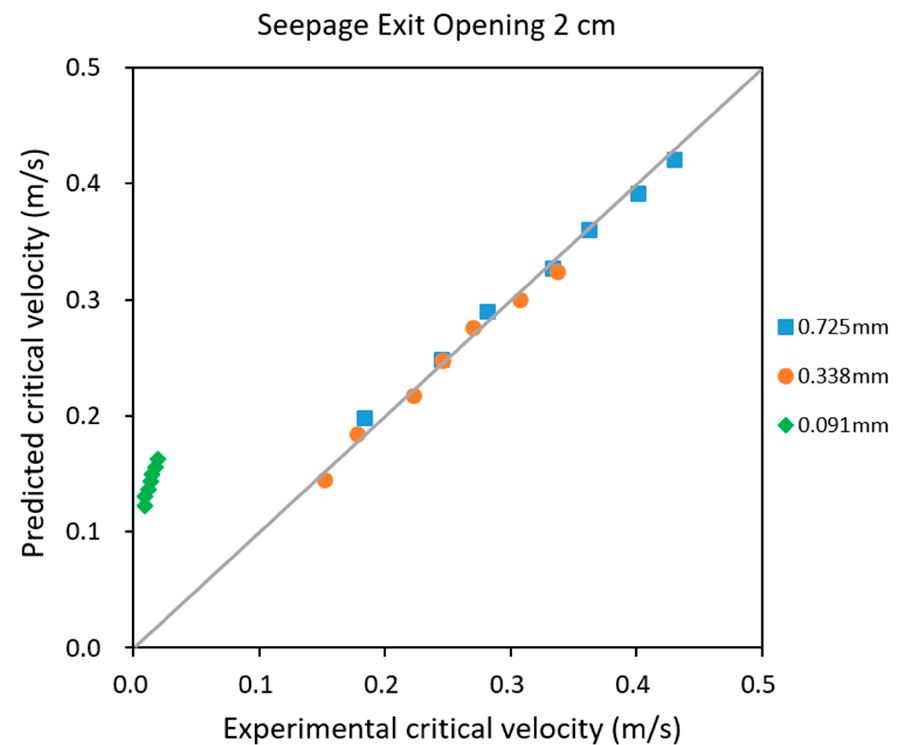
Figure 10. Comparison between predicted and experimental results with the seepage exit opening of 2 cm.